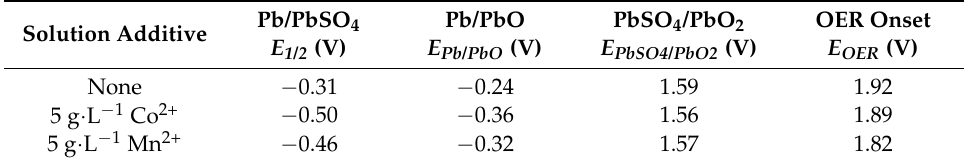
Table 2. Quantification of cathodic shifts in CV features as catalytic metal additives are included in solution. The Pb/PbSO 4 redox couple represents a quasi-reversible process, while the others reported below are irreversible.